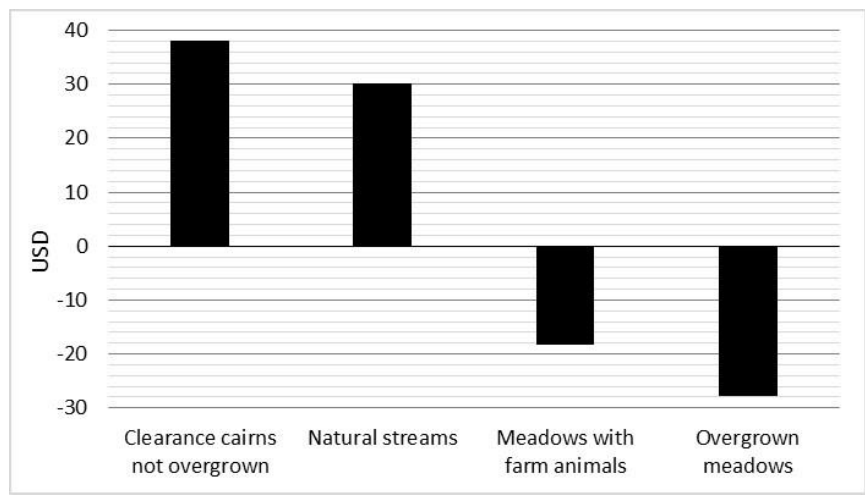
Figure 4. Marginal willingness to pay for the attribute change (in USD per one-way trip/person) (source: authors).